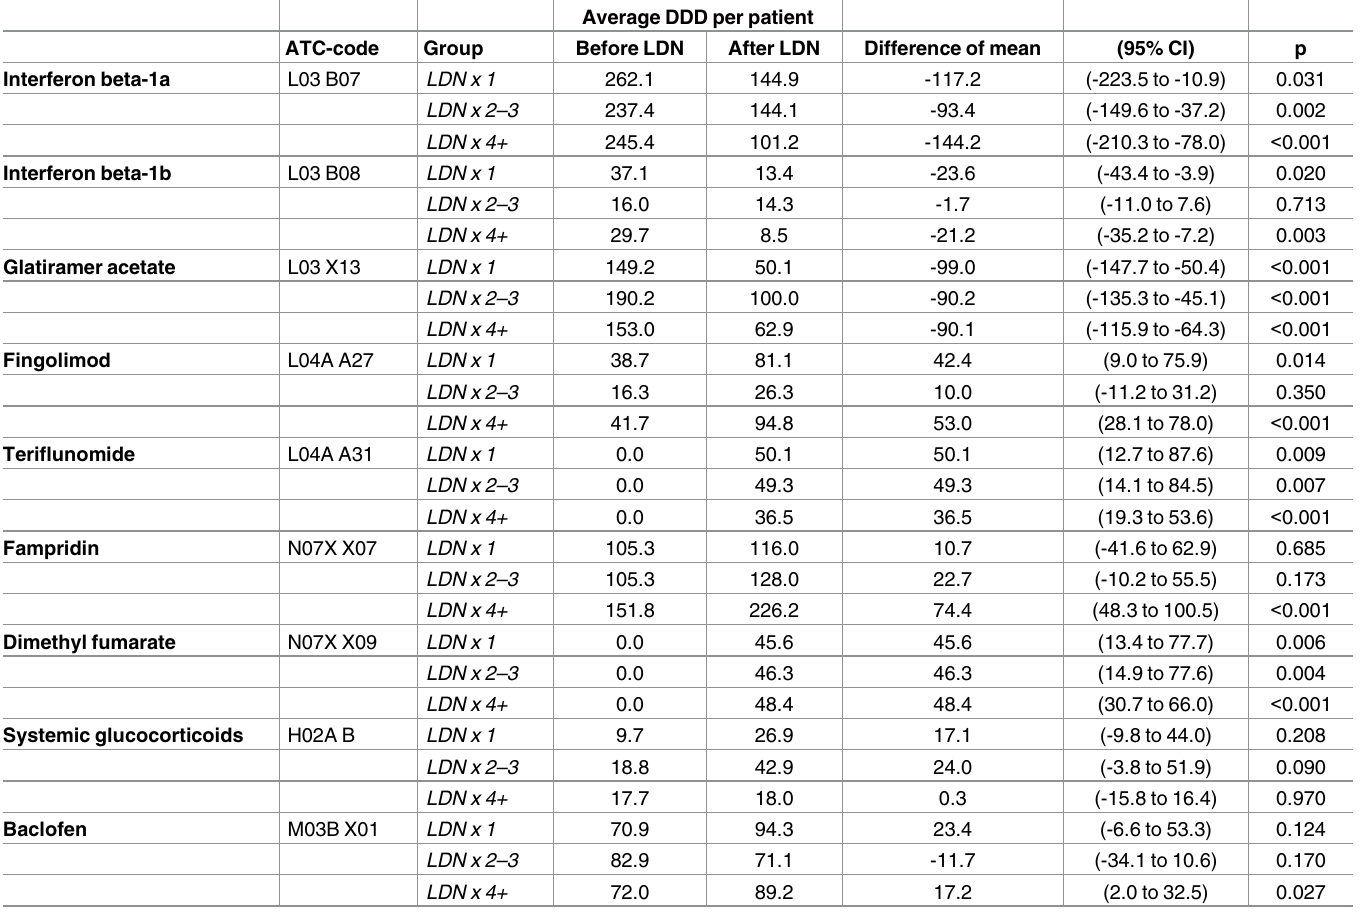
Table 2. Differencein use of disease modifying MS drugs, systemicglucocorticoids and baclofen two yearsbefore and after first LDN prescription by number of LDN dispenses to